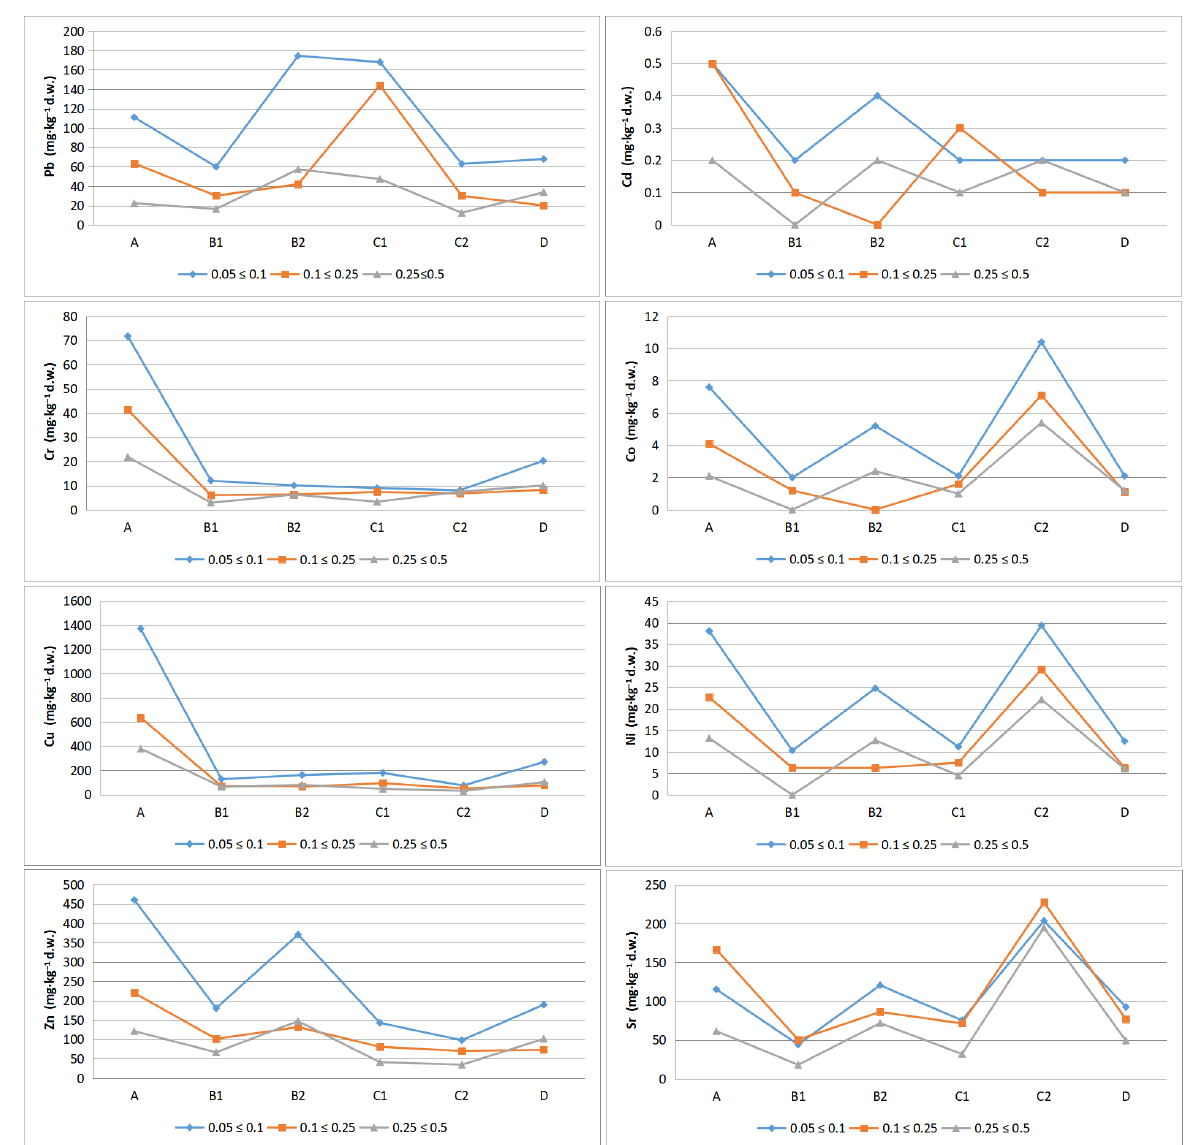
Figure 5. Potentially harmful elements (PHEs) content (mg·kg − 1 d.w.) in different grain size fractions (mm) according to sampling location: A (inter-railway, depth 20 cm), B1 (5 m from the main track, depth 0–5 cm), B2 (5 m from the main track, depth 20 cm), C1 (embankment, 10 m from the main track, depth 0–5 cm), C2 (embankment, 10 m from the main track, depth 20 cm), D (side track, depth 20 cm).